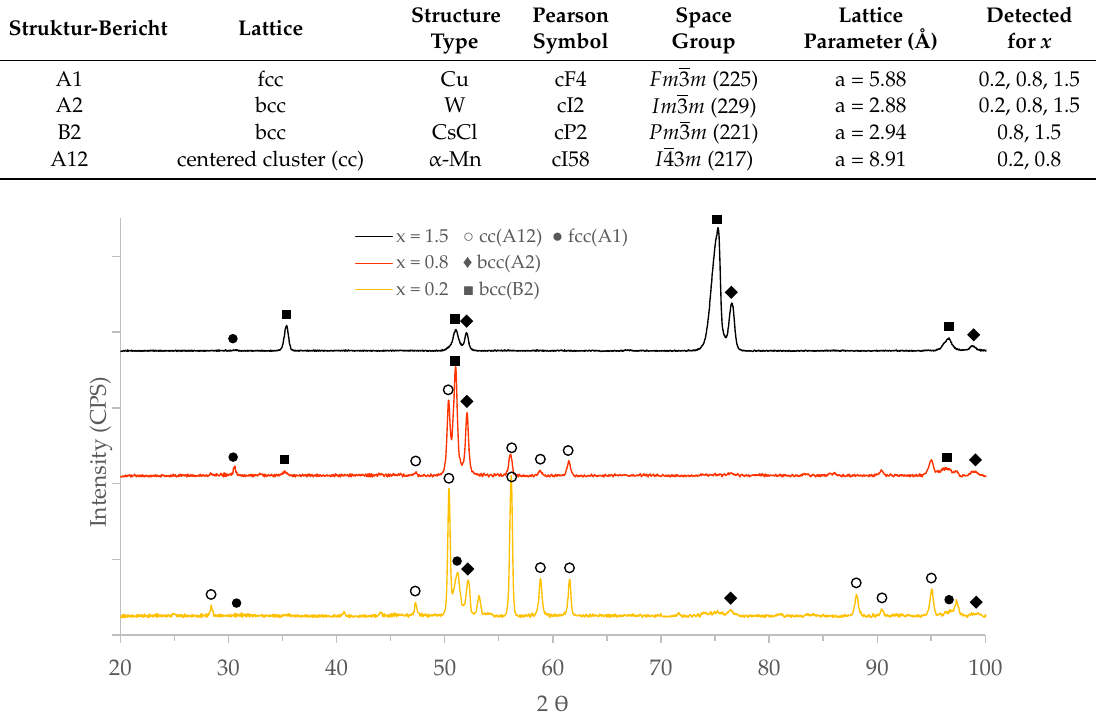
Table 5. List of phases detected by X-ray diffraction (XRD) measurements.